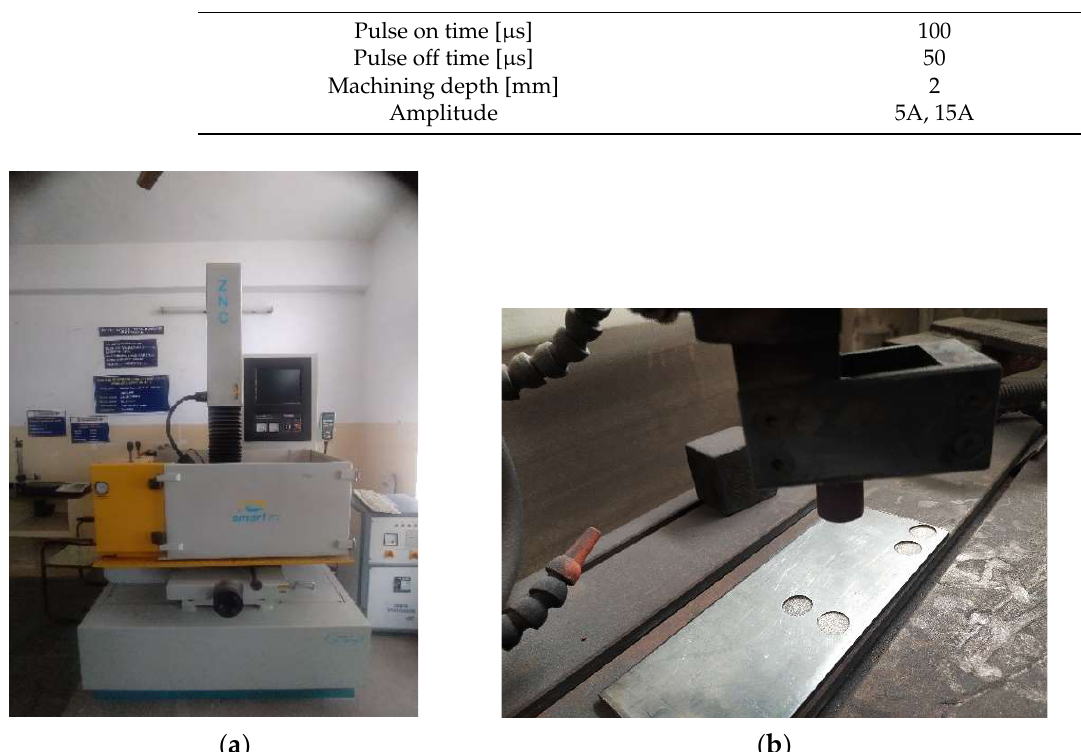
Figure 2. Experimental Setup. ( a ) EDM Machine; ( b ) Tool with workpiece on EDM